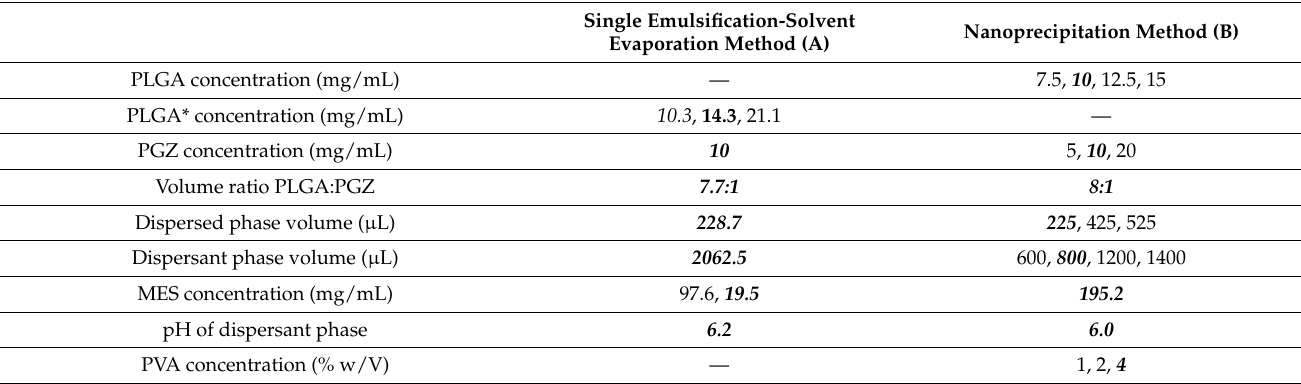
Table 1. Parameters used in pioglitazone-loaded PLGA nanoparticles synthesis and purification; in italic, the parameters found for the best synthesis; in bold the standard ones, while in different syntheses mostly only one of the other multi-valued parameters was changed. The concentration values refer to the concentration within the used stock solution, not to the one in the final